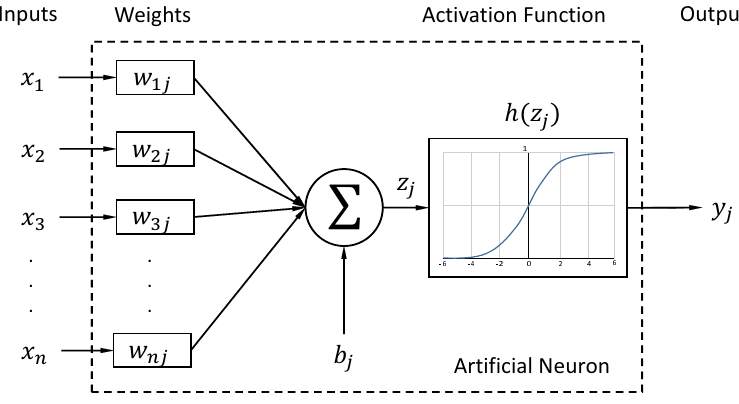
Figure 1. Structure of the artificial